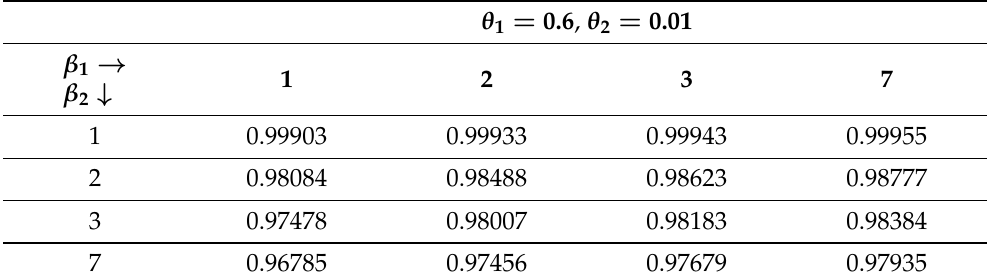
Table 4. Numerical values of Re Stress − Strength associated with the DPsL distribution at θ 1 = 0.6, θ 2 = 0.01 for different values of β 1 and β 2 .